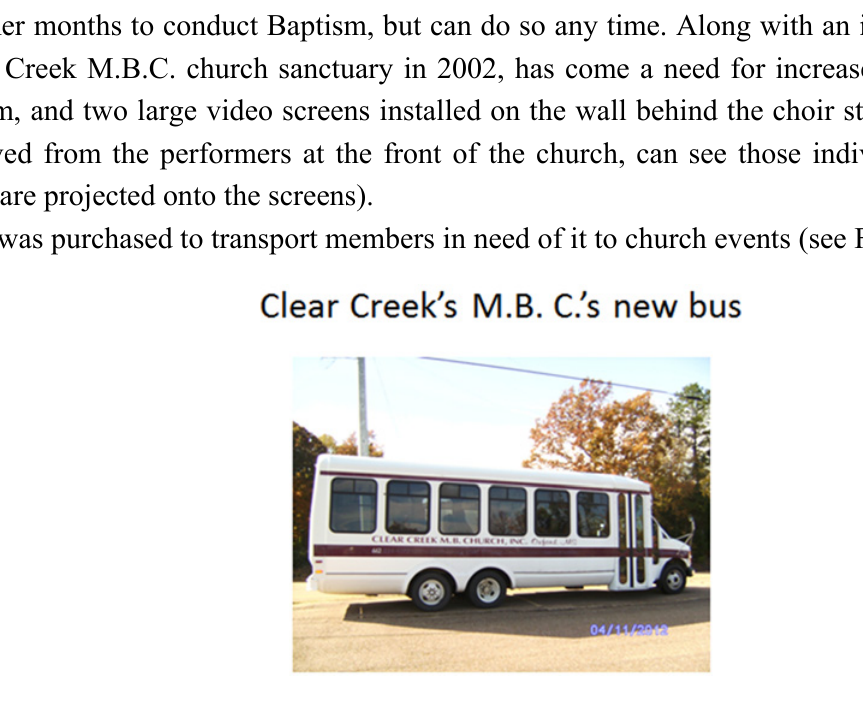
Figure 2. The Clear Creek M.B.C.bus, November